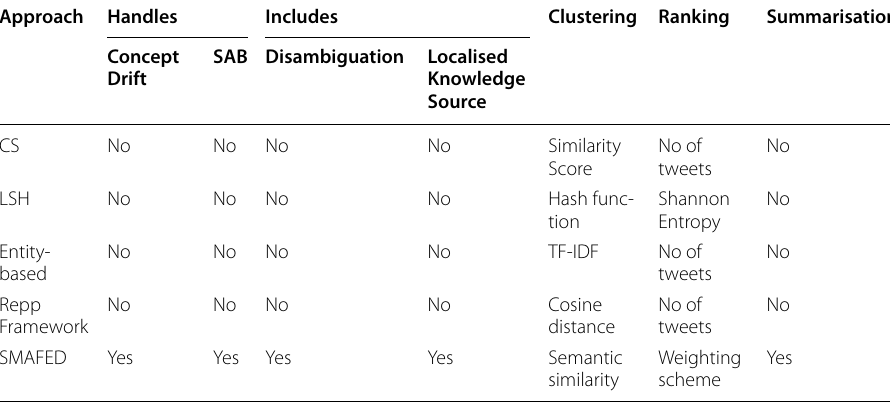
Table 17 Comparison of smafed against other Frameworks in terms of scope, coverage and approach Approach Handles Includes Clustering Ranking